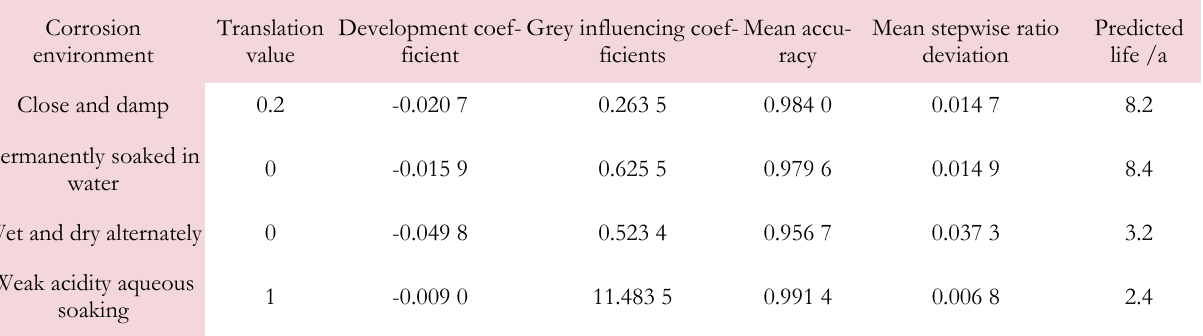
Table 4: Parameters and grey prediction results of GM (1,1)